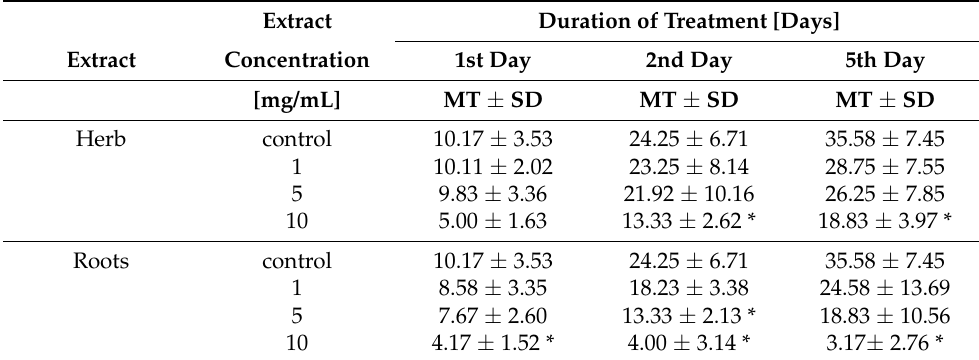
Table 3. The effect of the crude 80% aqueous methanolic extracts from the herb and roots of Lychnis flos-cuculi at different concentrations on Acanthamoeba trophozoite inhibition during five-day treatment.